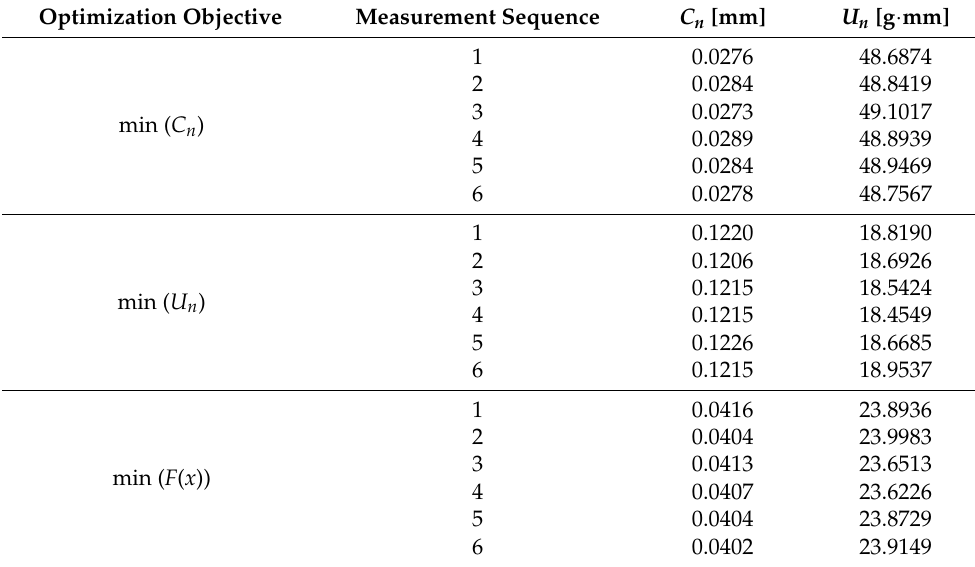
Table A5. Six times measurement results of the coaxiality and unbalance of the high-pressure rotor